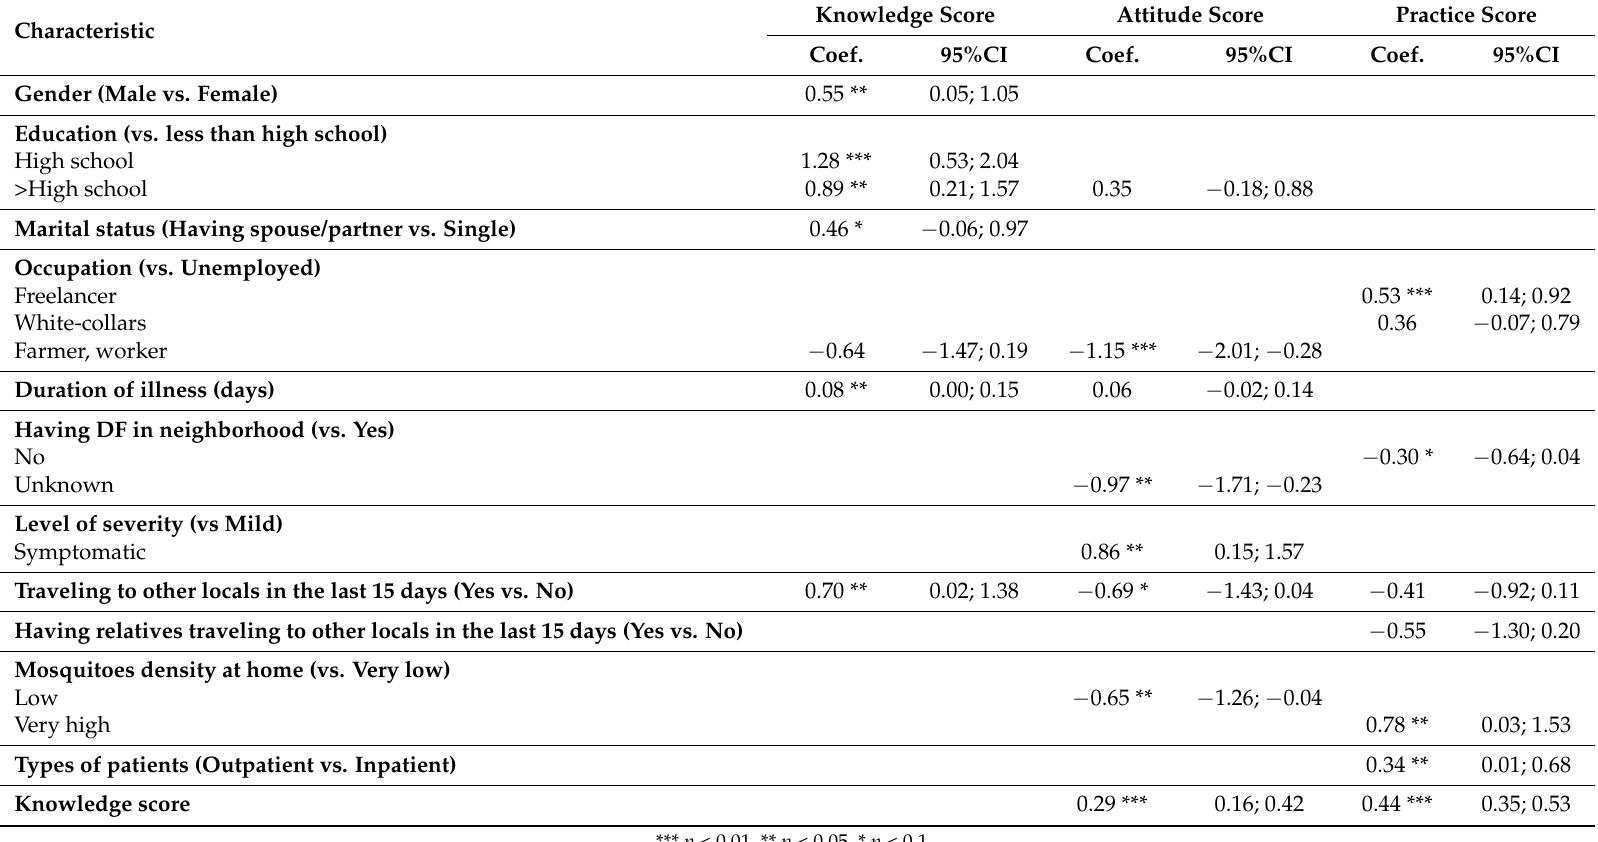
Table 6. Associated factors with KAP about